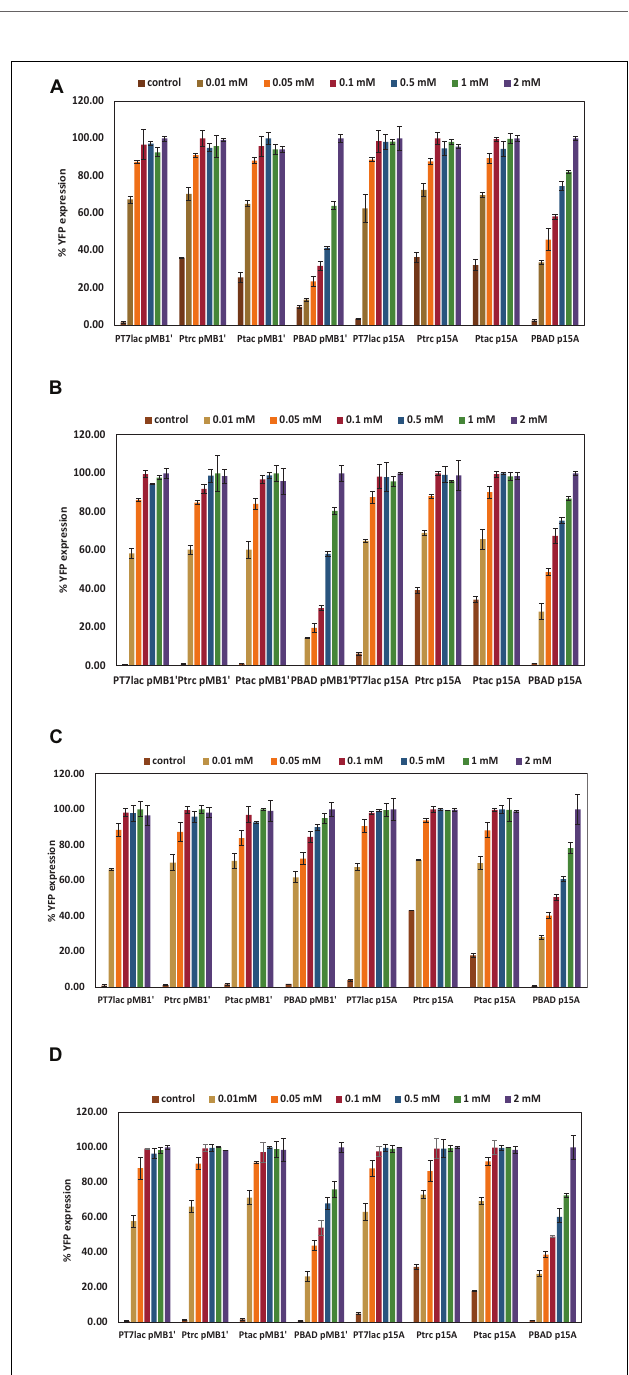
FIGURE 2 | Percentage of yellow fluorescent protein (YFP) expression with respect to maximal expression for each plasmid under different inductor conditions. The YFP expressions selected were the highest achieved at stationary growth phase. (A) E. coli wt growing with glucose as carbon source. (B) E. coli wt growing with glycerol as carbon source. (C) E. coli (cid:49) ackA growing with glucose as carbon source. (D) E. coli (cid:49) ackA growing with glycerol as carbon